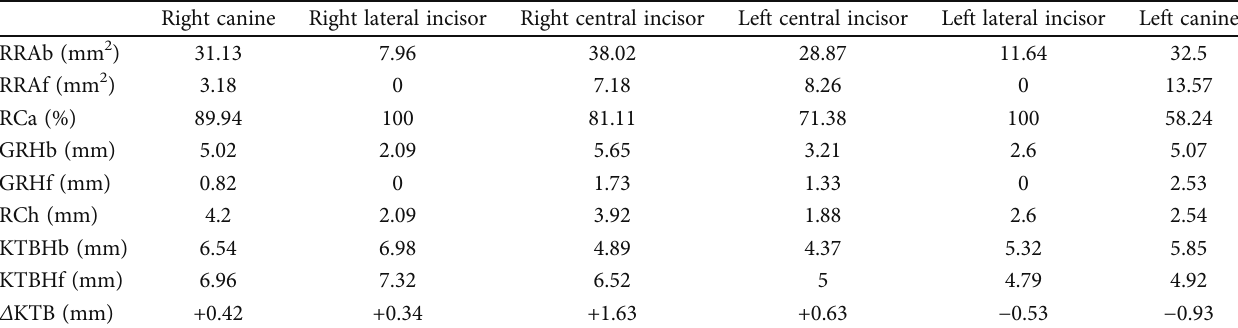
Figure 3: Baseline and 12-month follow-up measurements. (a) Baseline measurements: root recession area (blue); gingival recession height (black line in the blue area); keratinized tissue band (green); keratinized tissue band height (black line in the green area), (b) 12-month follow-up measurements: root recession area (blue); gingival recession height (black line in the blue area); keratinized tissue band (green); keratinized tissue band height (black line in the green area). Table 1: Measurements of gingival recession area, root coverage area, gingival recession height, root coverage height, and keratinized tissue band height, at baseline and 12 months after the surgical